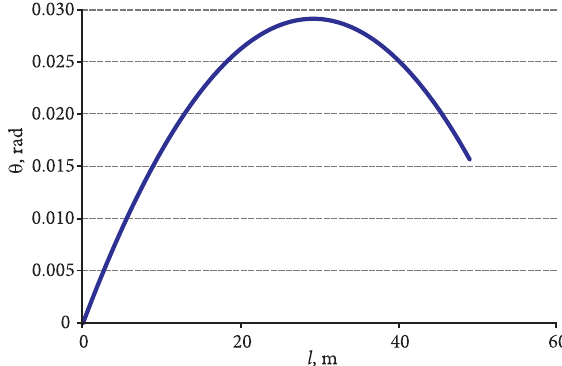
Fig. 2. Slope of the tangent θ( l ) chart, described by formula (13), for S- shaped joining of circular arcs with curvatures rad/m and rad/m ( l k = 50